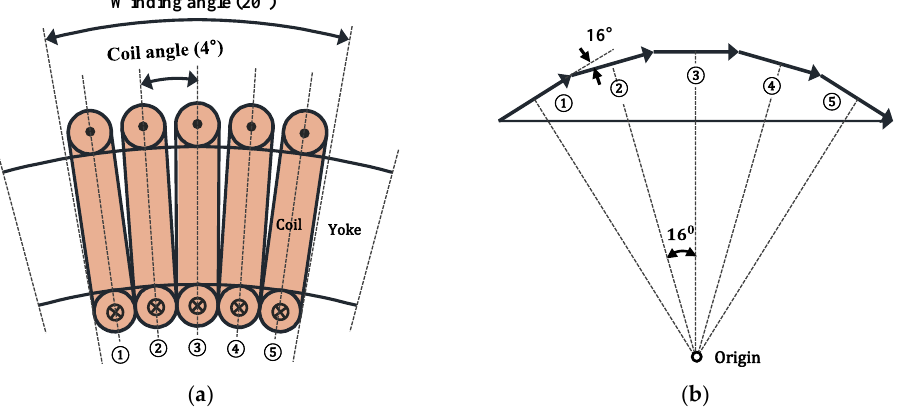
Figure 8. Winding factor of the TSLM: ( a ) Coil structure; ( b ) Coil vector diagram.